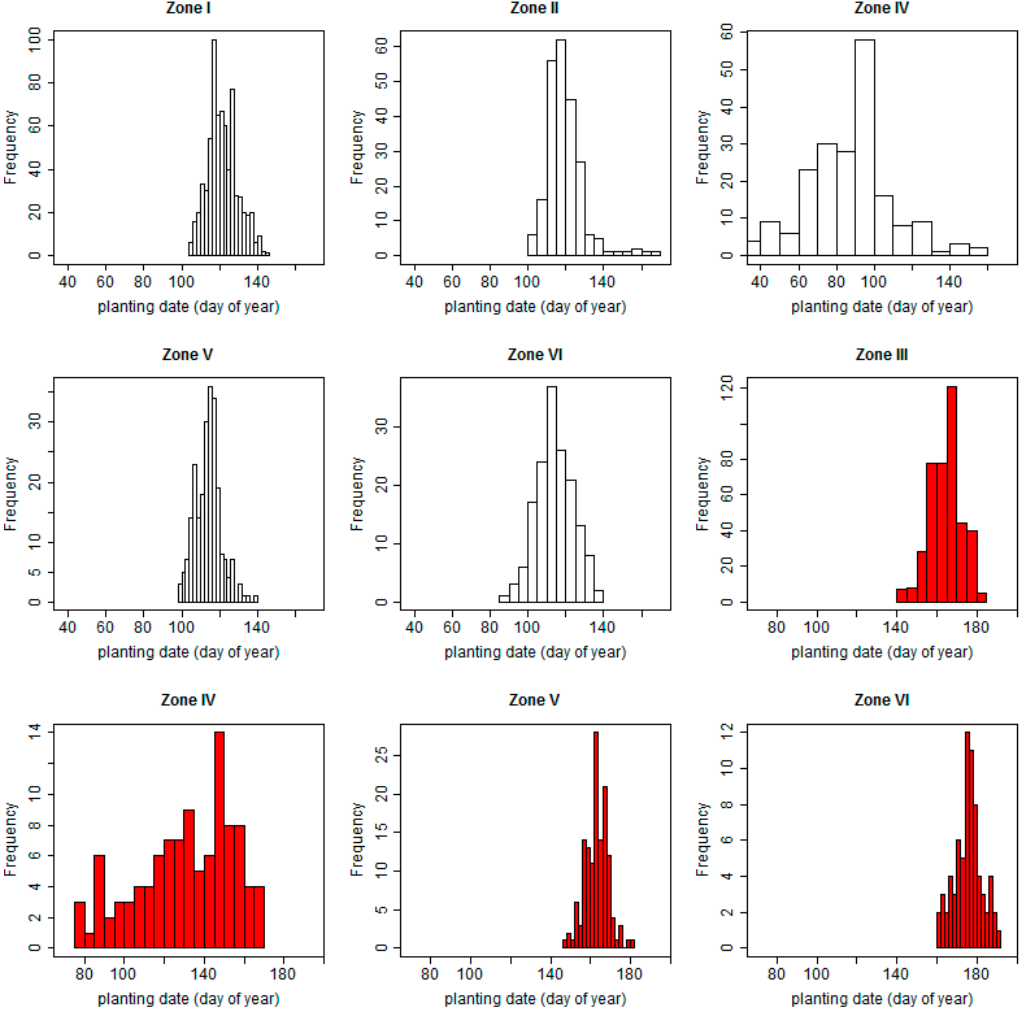
Figure 2. The planting dates distribution including spring maize (white) and summer maize (red), by days of year in six Zones during 1992–2010.